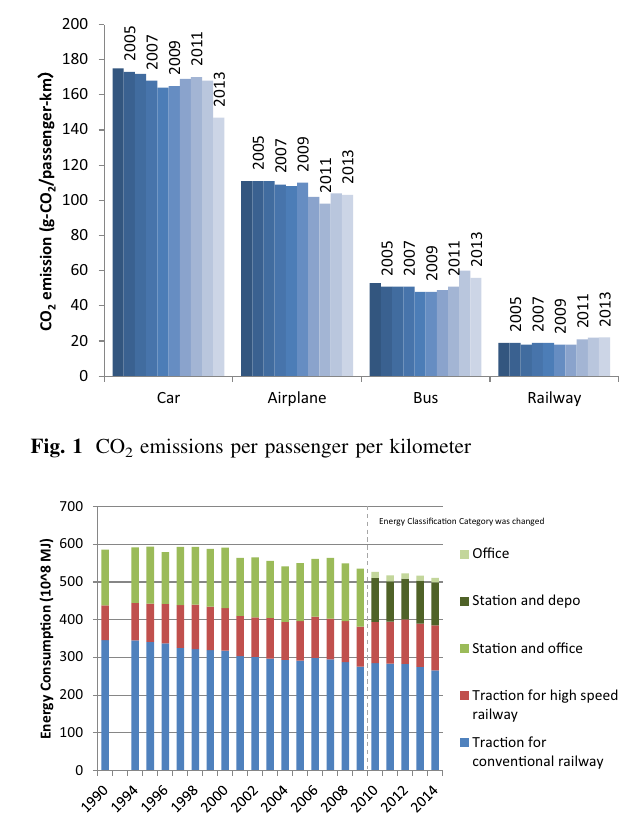
Fig. 2 Change in energy consumption in East Japan Railway Company (JR East)